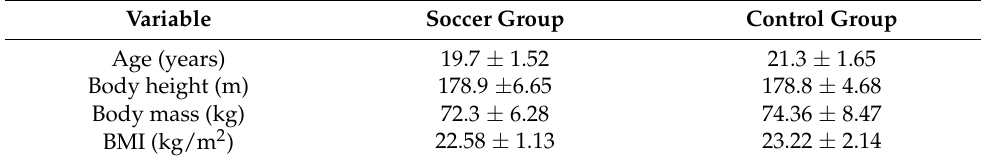
Table 1. Anthropometric characteristics of the